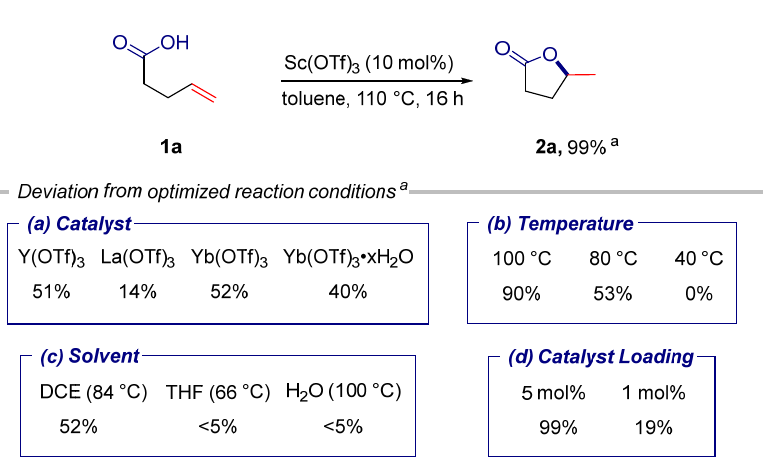
Figure 2. Optimization studies for rare-earth triflate-catalyzed γ -methyl- γ -butyrolactone formation by alkene hydrofunctionalization. a yields were determined by 1 H NMR using 1,3,5-trimethoxybenzene as the internal standard.